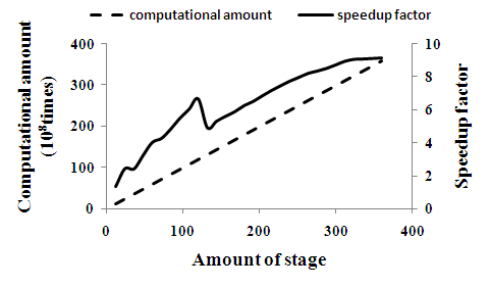
Fig. 8 The relationship between computation scale, speedup ratio, and stage